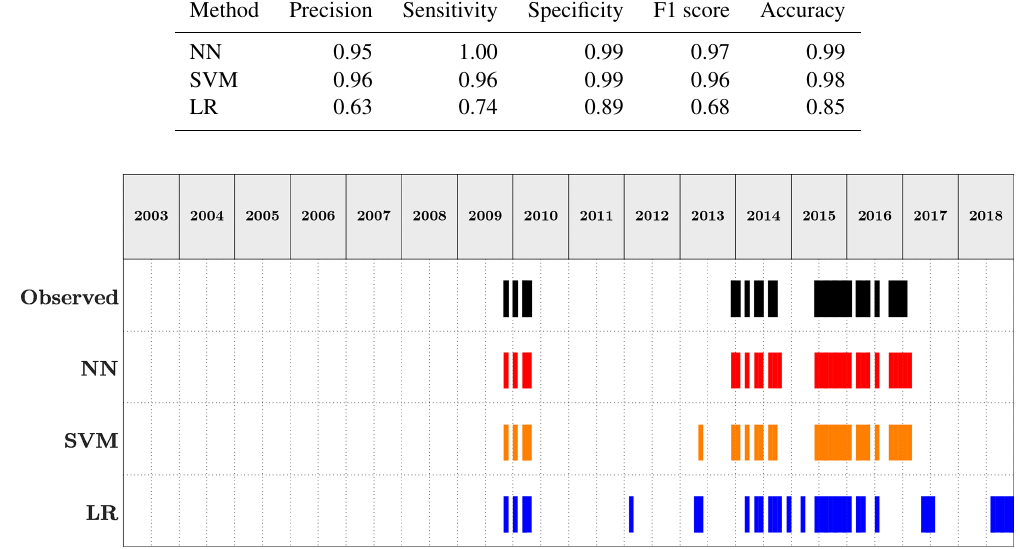
Figure 12. Comparison of the predictions of the three methods over the testing set vs. the observed events. Drought case.